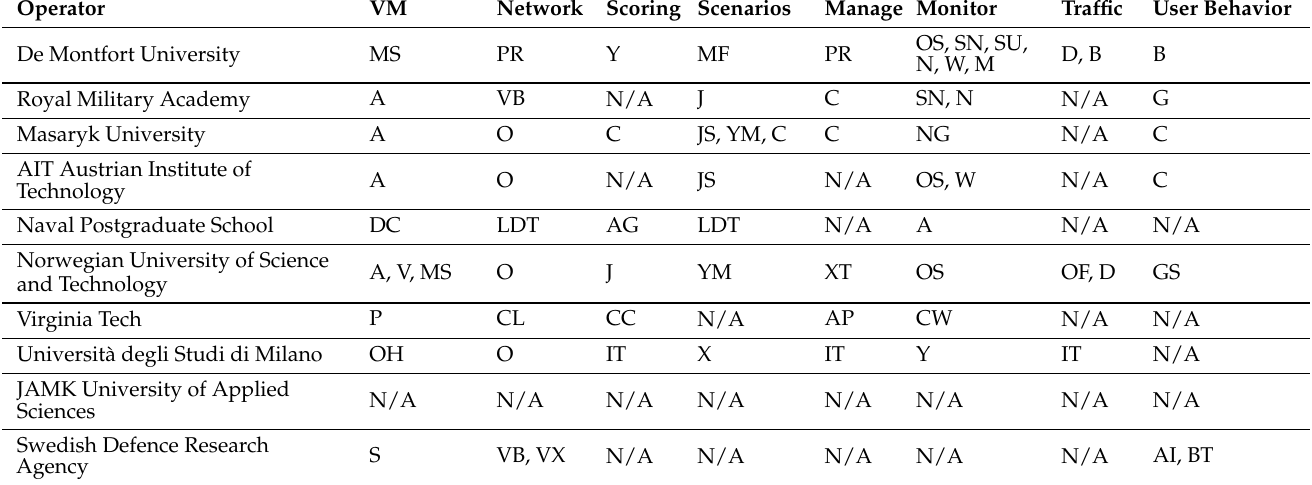
Table 4. Cyber Ranges’ tools.